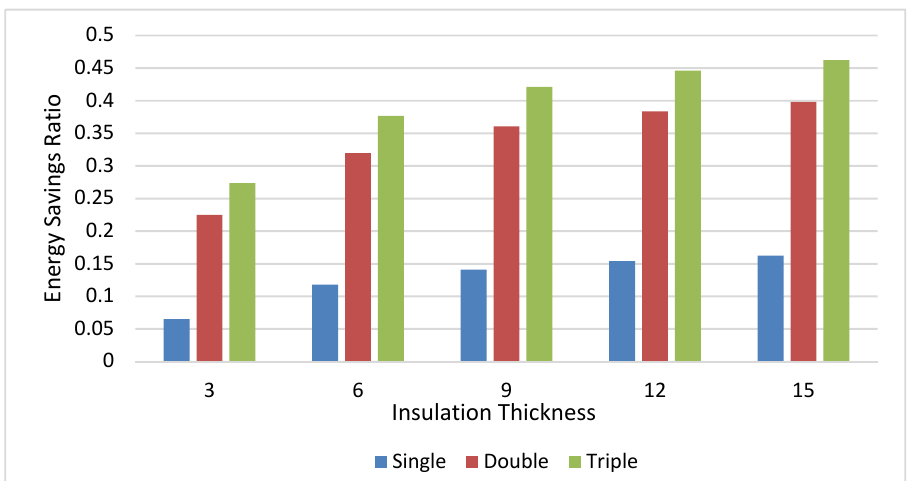
Figure 14. Energy savings ratio versus varying insulation thicknesses and glazing types for the designed zone in Hakkari (40% WWR).